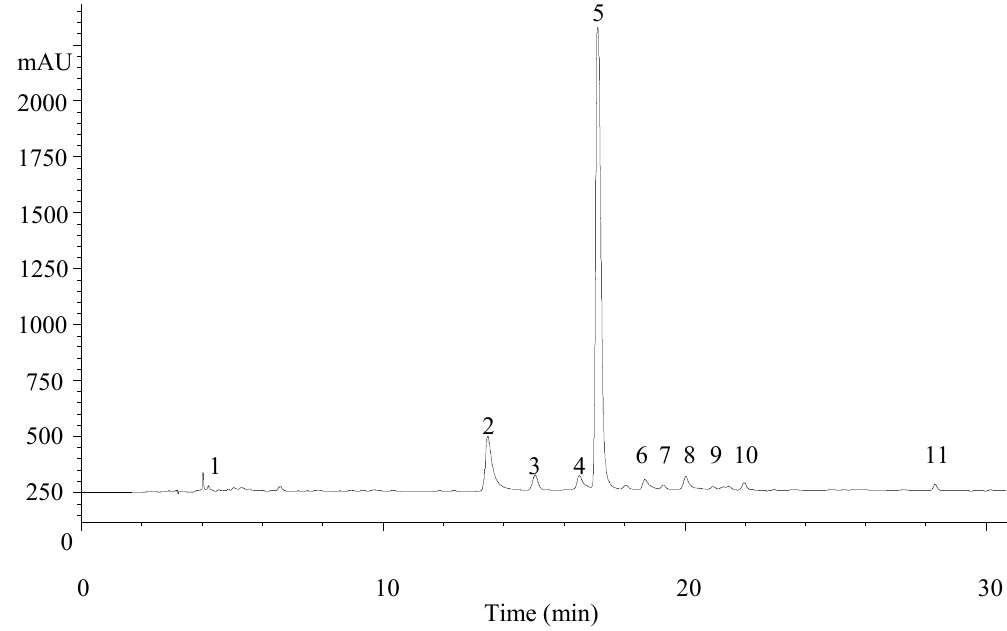
Figure 1. Aloysia citrodora phenolic profile recorded at 280 nm. Peak numbering is the same as in Tables 1 and 2.